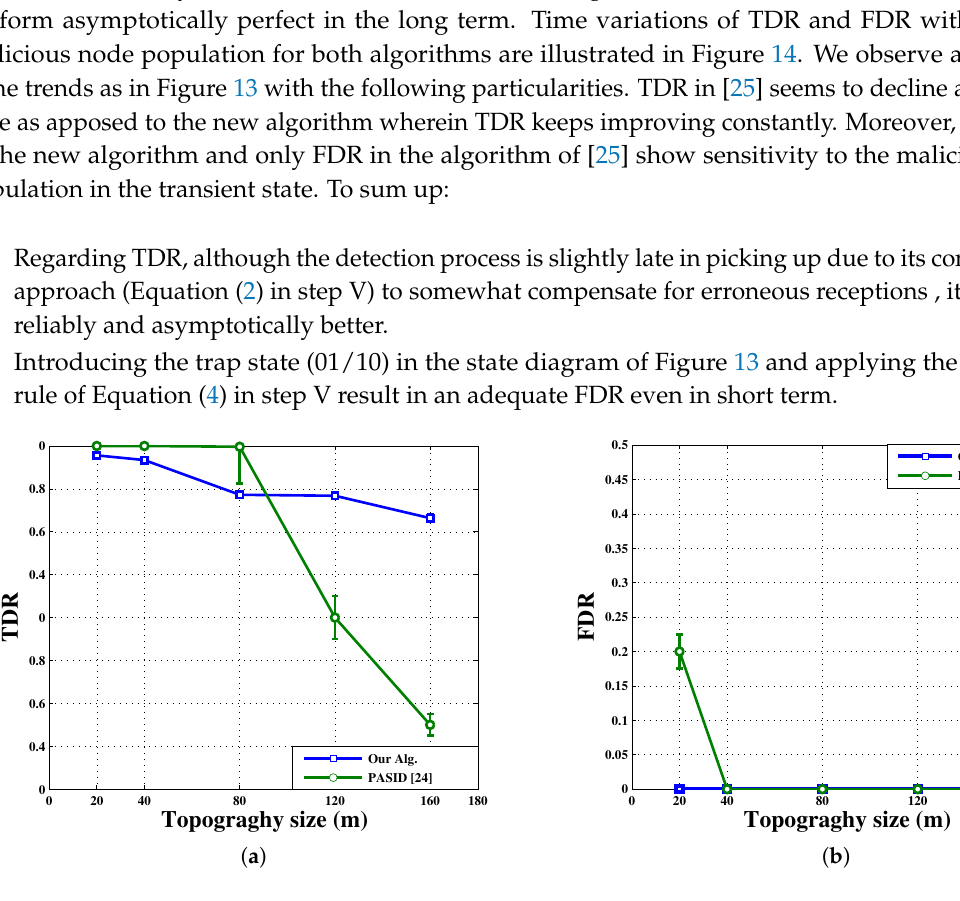
Figure 12. Performance comparison of PASID and our new proposed method in terms of TDR ( a ) and FDR ( b ) versus the topography.